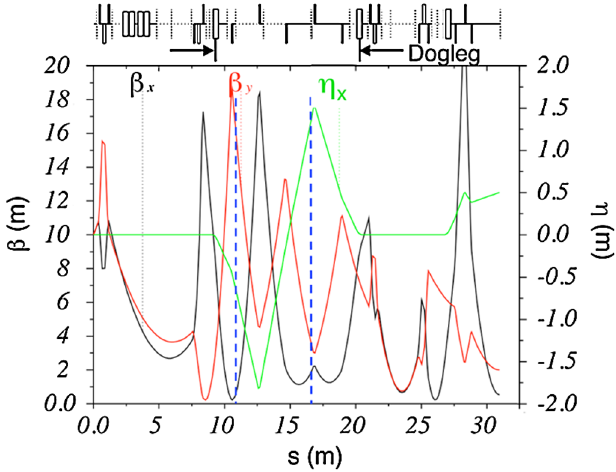
FIG. 1. (Color) Beam beta functions ( (cid:4) x black line, (cid:4) y red line), and dispersion in the x plane (cid:7) x (green line) obtained using the MAD program. The beam line elements are shown in the figure above the graph. Quadrupoles focusing in the x ( y ), horizontal (vertical) direction are indicated by thin rectangles above (be- low) the middle line, dipoles by full rectangles across the middle line, and beam profile monitors by the dotted lines. The blue dashed lines represent the location of the energy slit (left-hand side line) and of the mask (right-hand side